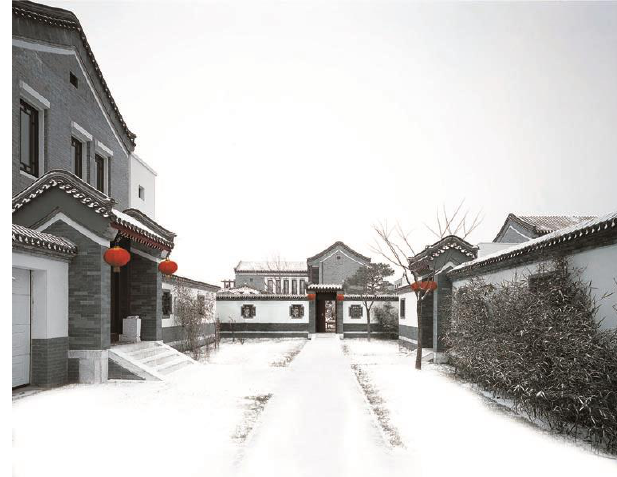
Figure 12. Snow scene of a Guantang alley, reminiscent of a traditional Beijing’s hutong (lane). Source: Beijing Institute of Architectural Design 2014.